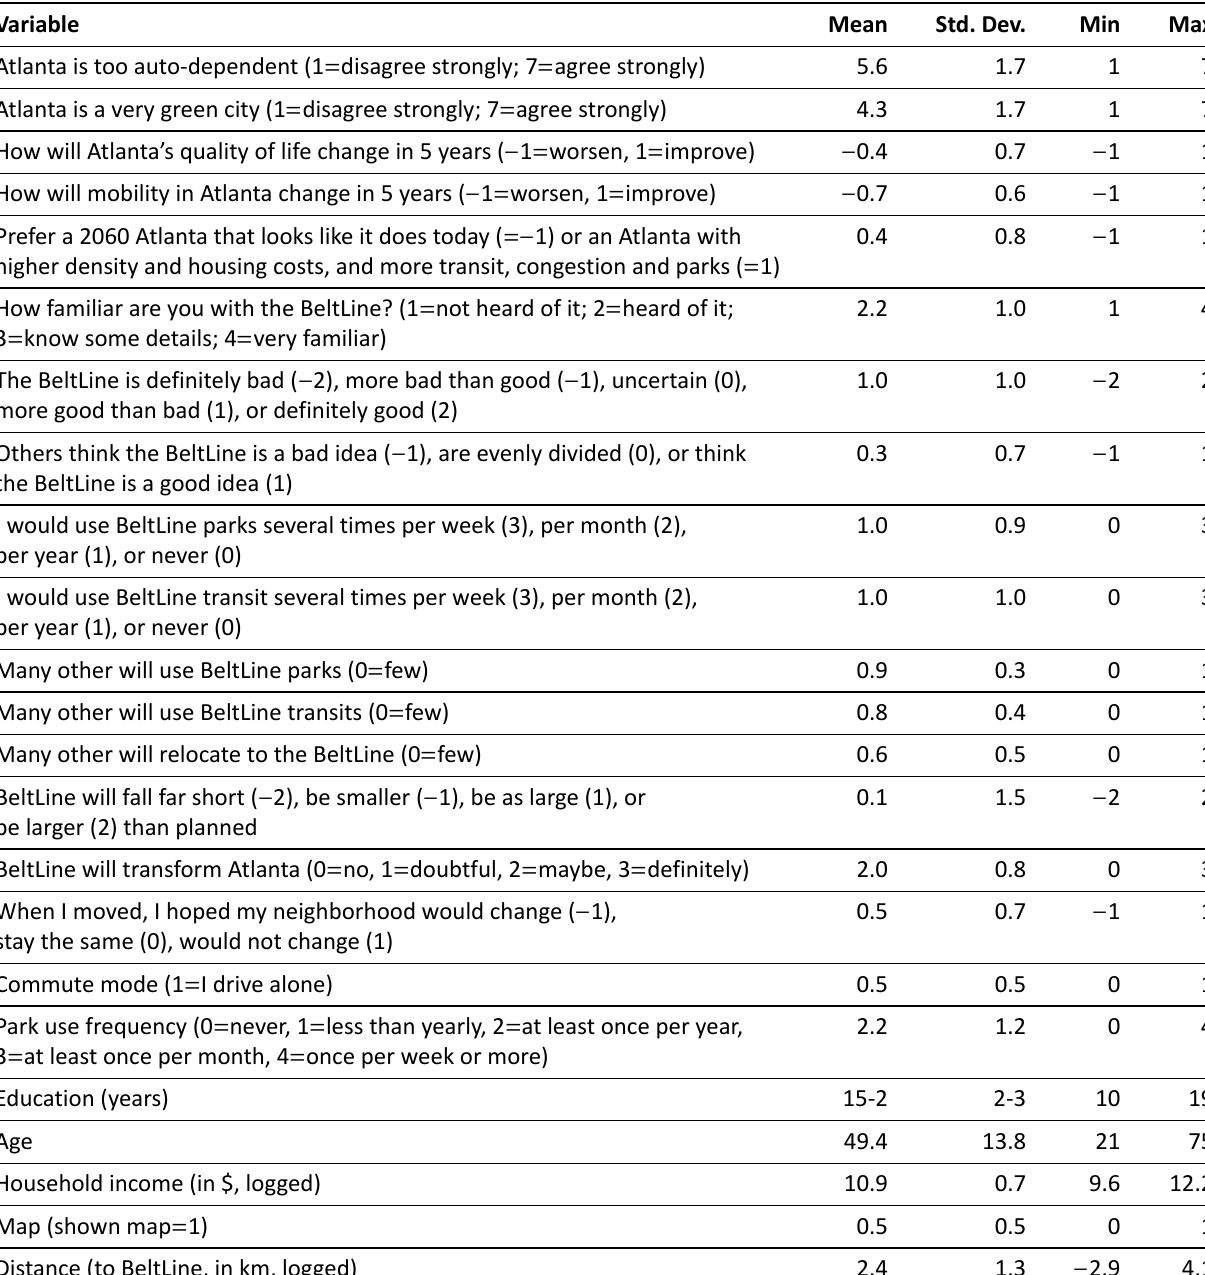
Table 3. Descriptive statistics from survey